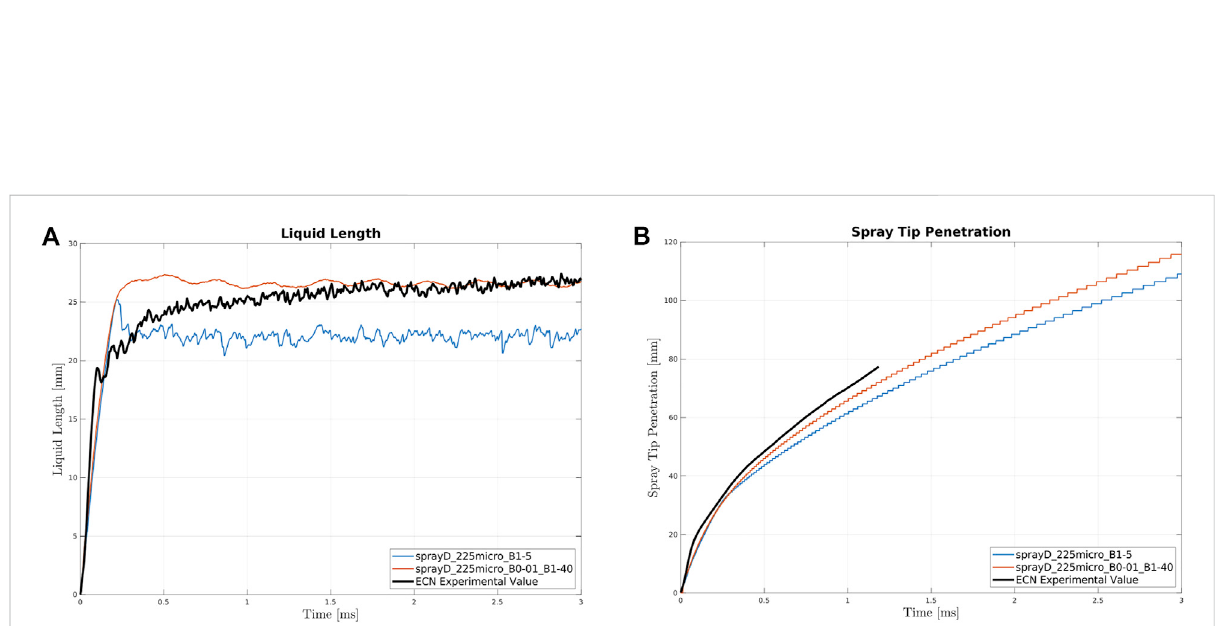
break-up model constants for the speci fi c benchmark and turbulence model. The comparison is between the results obtained using the constants adopted in this work for compromise and the results obtained using constants obtained fi ne tuning each case alone.